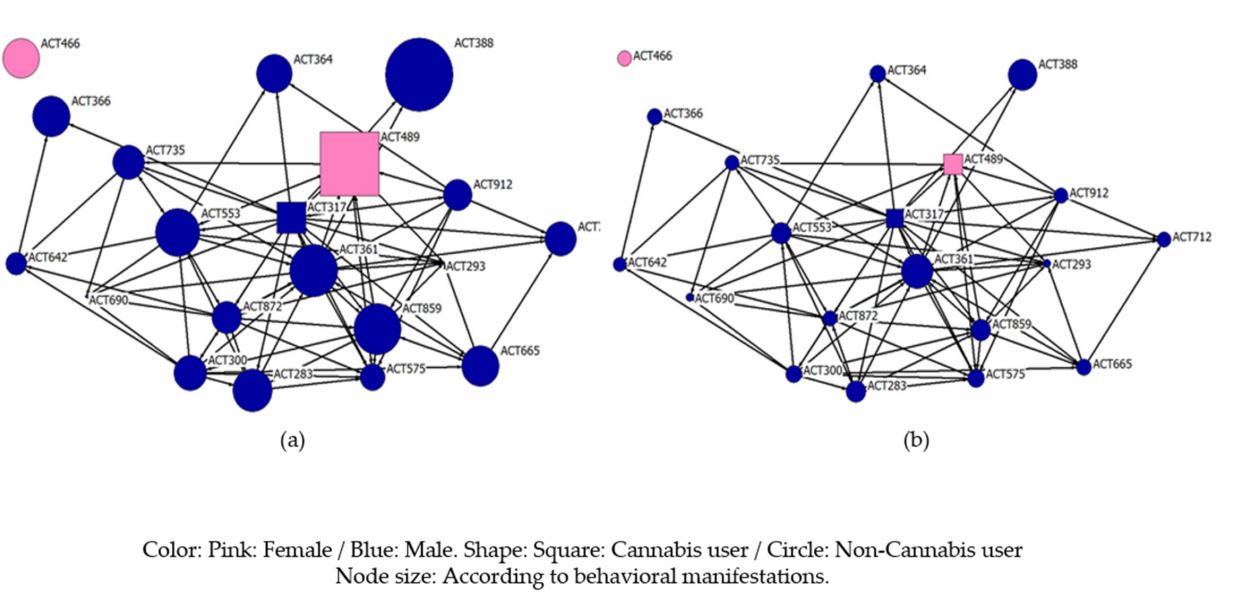
Figure 3. Consumption network structure and the study variables; ( a ) total of Student Stress Inventory–Stress Manifestations, ( b ) behavioral of Student Stress Inventory–Stress